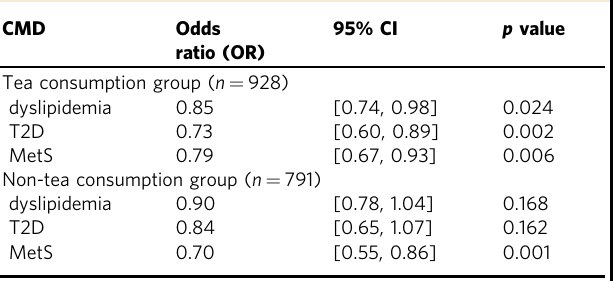
Table 3 The strati fi ed analysis of the association of Ruminococcaceae UCG-002 with CMD risk by tea consumption (yes versus no) in the Guangzhou Nutrition and Health Study a